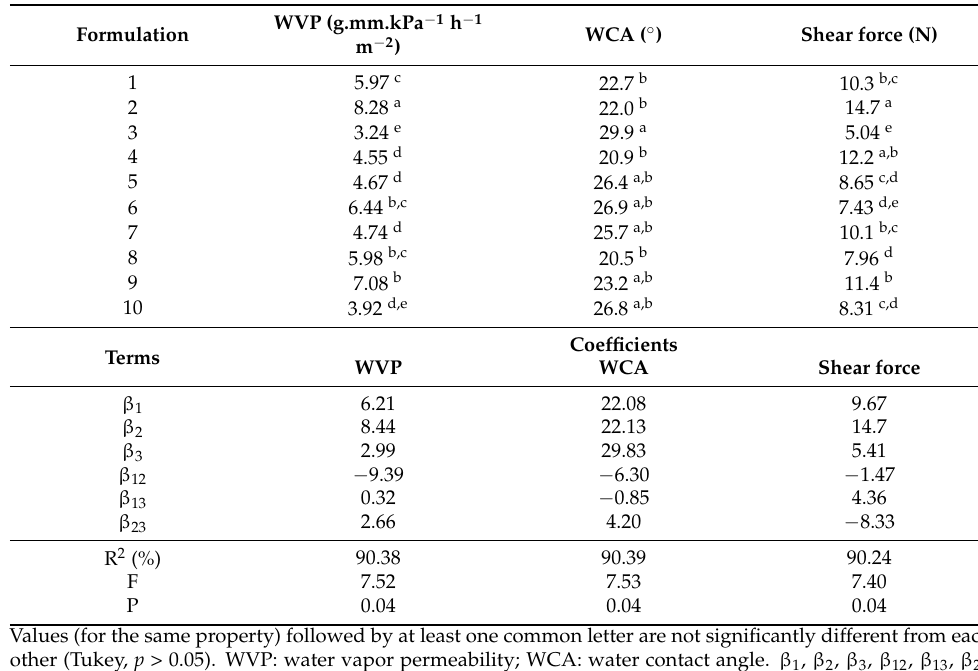
Table 1. Properties of films from different formulations and regression coefficients (in pseudo- components).